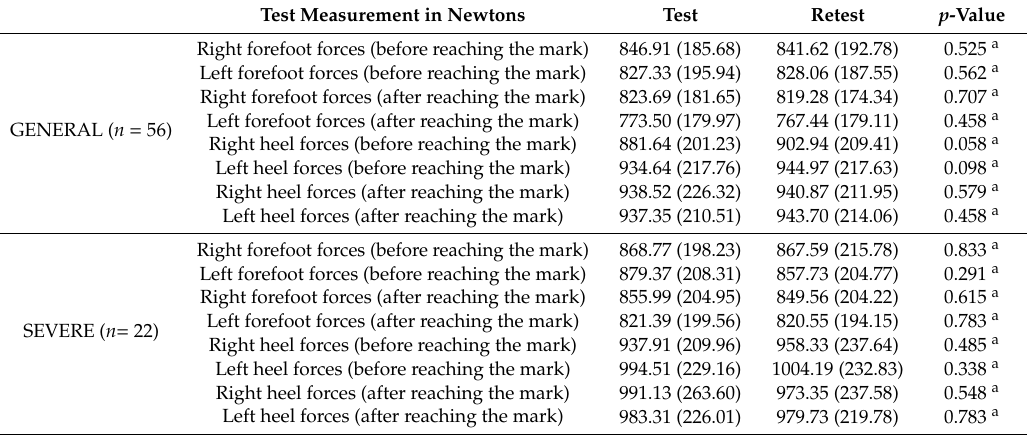
Table 4. Di ff erences between the test and retest on the peak forces from the heel and the forefoot forces in the entire sample and in participants with (a) severe neuropathy, (b) moderate neuropathy and (c) normal